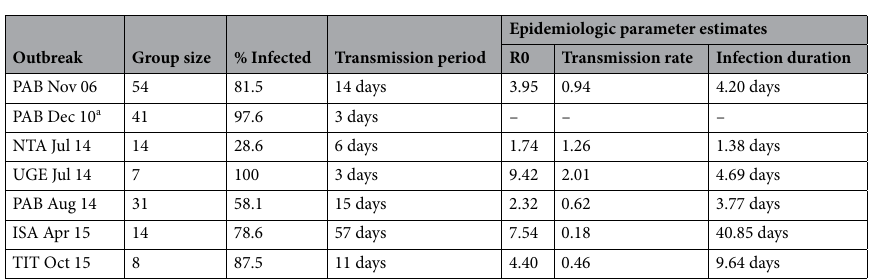
Table 1. Outbreaks (group code, month and year) for which within-group transmission was examined. Transmission period was defined as the number of days from the first group member showing signs of infection to the last day on which a group member showed signs of infection for the first time. Epidemiologic parameters were estimated using SIR mathematical models. R0 refers to the basic reproductive number. Transmission rate refers to the number of subsequent infections per gorilla per day. a Epidemiologic parameters not estimated due to insufficient data collection to estimate infection